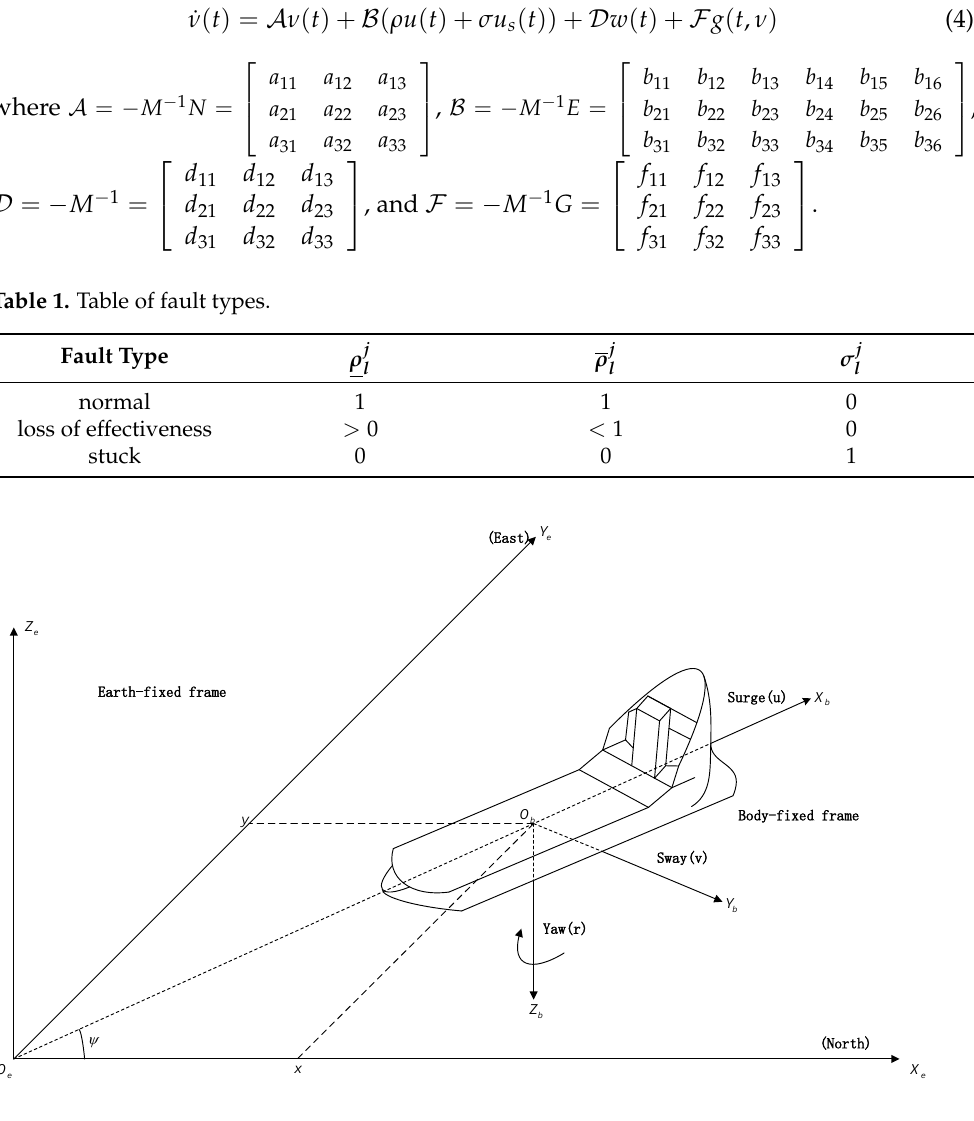
Figure 1. UMV in the reference coordinate